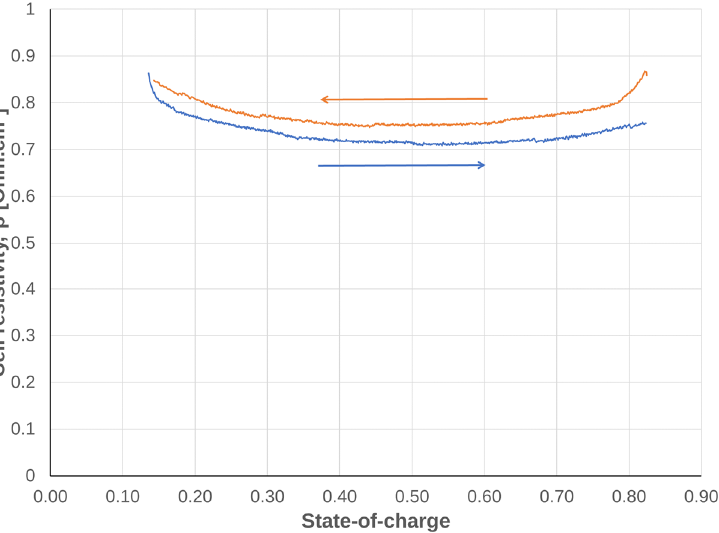
Figure 2. Resistivity of a vanadium flow cell, during charge (blue curve) and discharge (orange) arranged against electrolyte inlet state-of-charge, at 24.4 ± 0.3 °C electrolyte temperature.